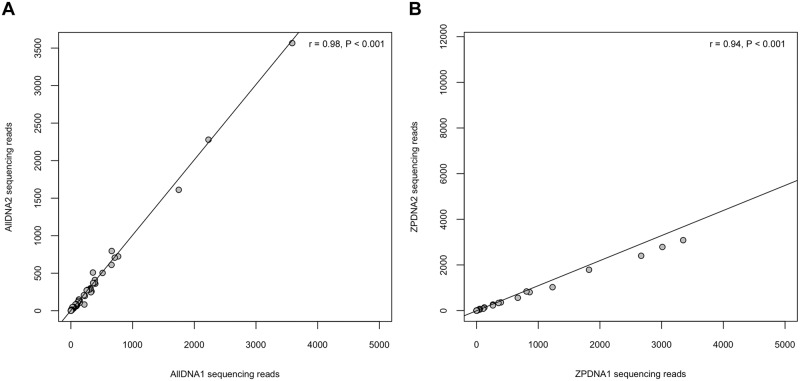
Read coverage distribution of sample aliquots inferred from pyrosequencing after clustering against the reference library at 99% similarity.
(A) Dataset showing strong positive correlation between aliquot 1 (x-axis) and aliquot 2 (y-axis) of pooled ALLDNA sample (Spearman r = 0.98, P < 0.001). (B) Dataset showing strong positive correlation between aliquot 1 (x-axis) and aliquot 2 (y-axis) of pooled ZPDNA sample (Spearman r = 0.94, P < 0.001).